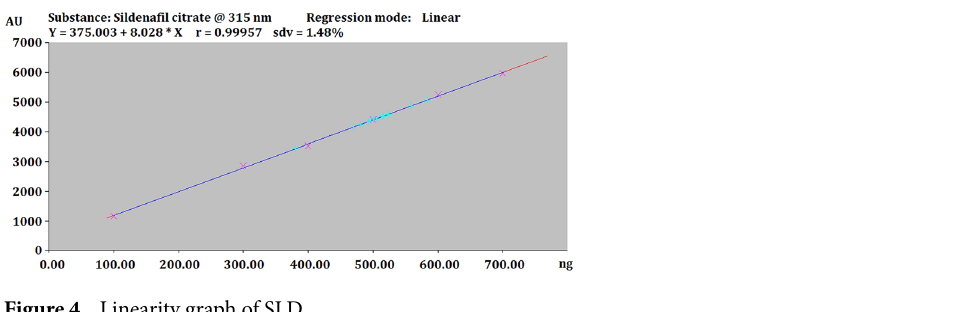
Figure 4. Linearity graph of